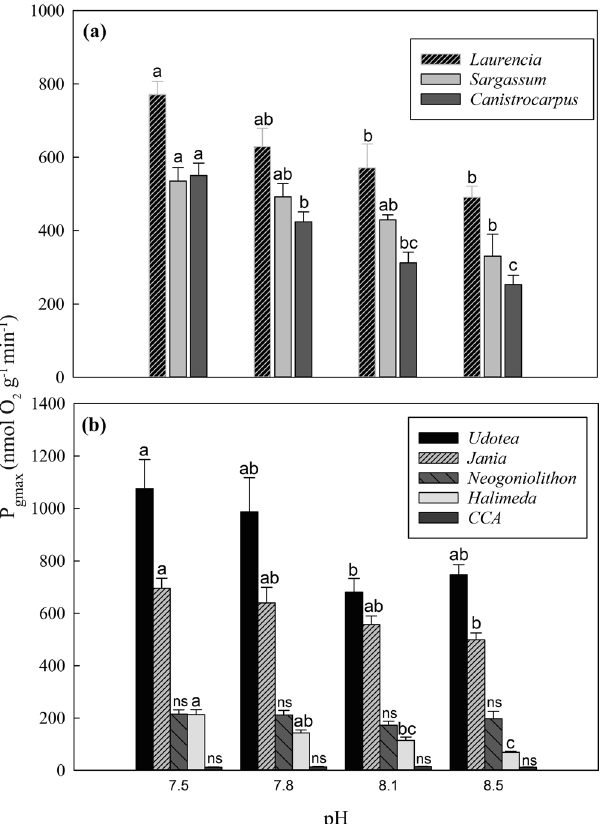
Figure 1. Maximum gross photosynthetic rates (P gmax ) for fleshy ( a ) and calcified ( b ) tropical macroalgae from the Florida Reef tract across a range of pH based on PI curves (Fig. S2). Different letters signify significant differences (P < 0.05) among pH treatments within species (n = 6–8). ns =